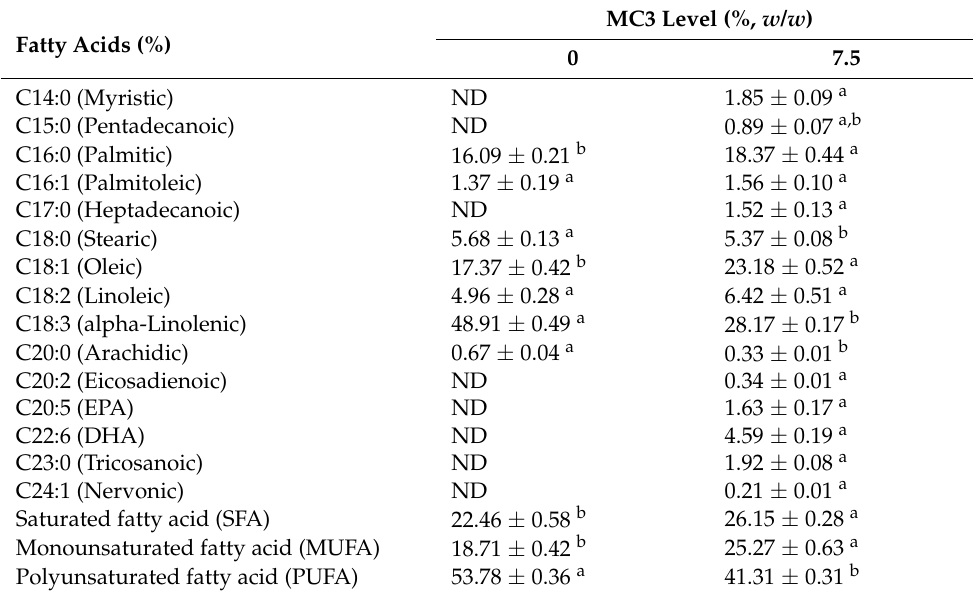
Table 6. Fatty acid profiles of whole wheat cracker and that fortified with 7.5%